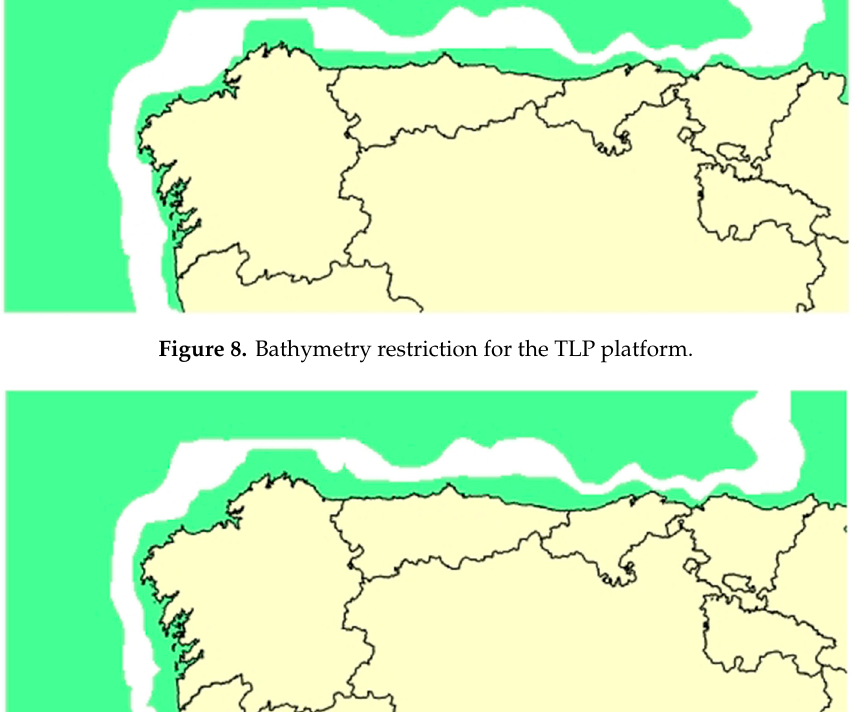
Figure 9. Bathymetry restriction for the spar platform.